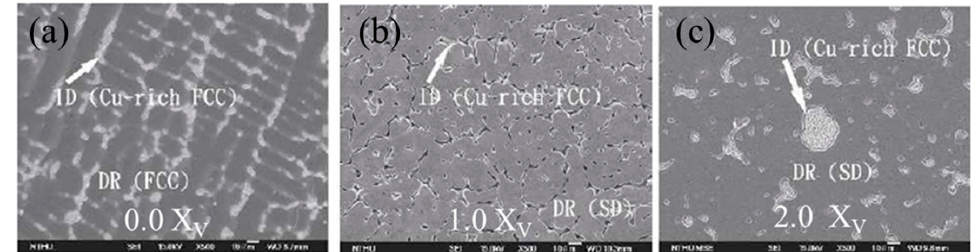
Figure 26. Microstructure of the Al 0.5 CoCrCuFeNi alloy at ( a ) 0.0, ( b ) 1.0 and ( c ) 2.0 mole fraction V. The initial microstructure had the lowest hardness value, which was observed to increase with increasing vanadium content. All three microstructures showed segregation of copper into inter- dendritic regions [90] (reprinted with permission from Springer).